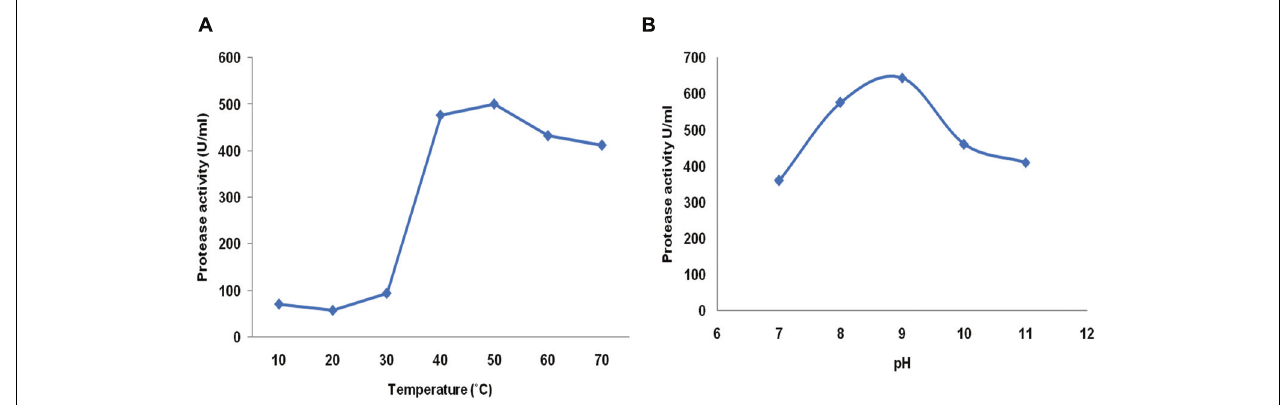
FIGURE 1 | Evaluation of enzyme activity at different (A) Temperature (10–70 ◦ C) and (B) pH (7–11) of Bacillus pumilus MP 27.